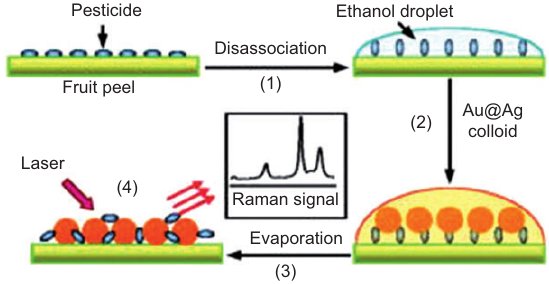
Figure 6 Illustration representing the direct detection of pesticide residues in fruit peels by SERS spectroscopy using Au@Ag NPs. Reproduced with permission from: Liu et al. (2012) . Copyright 2012, American Chemical Society.